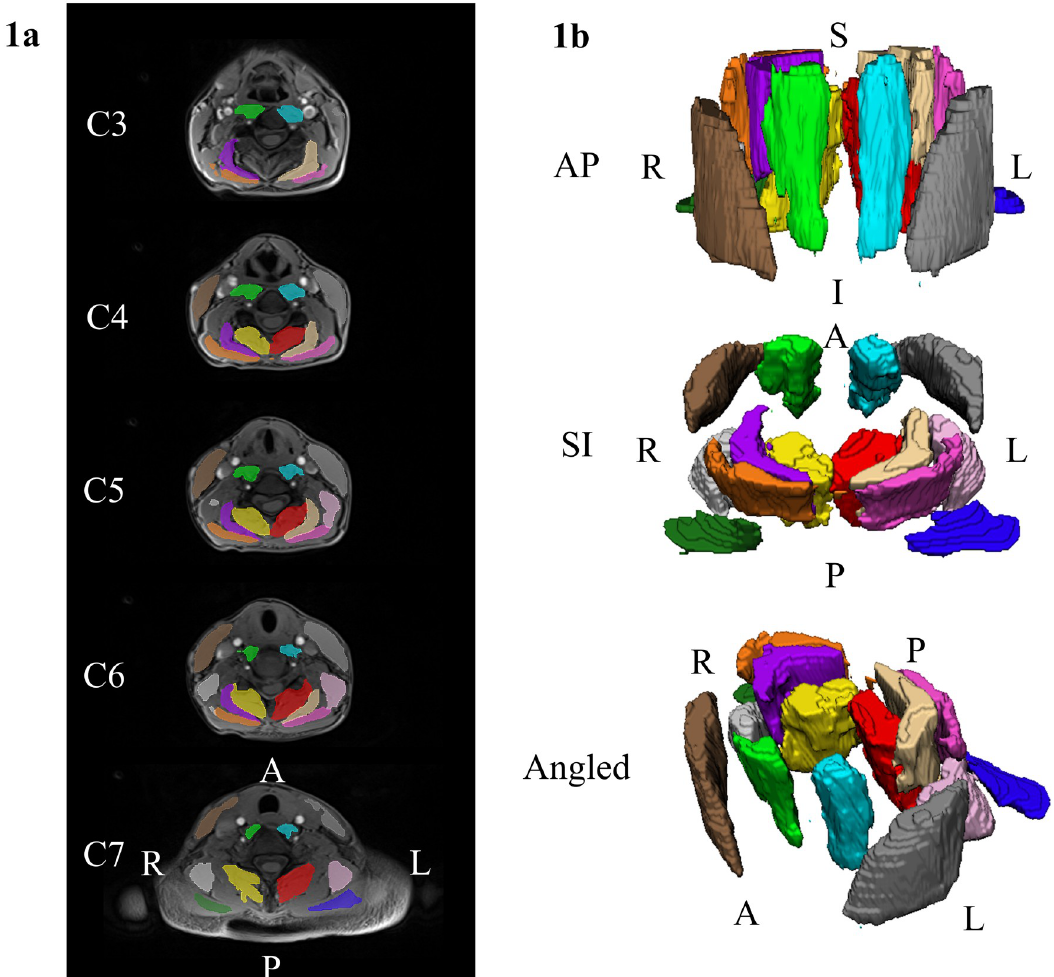
Fig 1. Example renderings of the cervical spine muscle segmentations. We used a previously developed convolutional neural network (CNN) to segment seven bilateral cervical muscles (14 muscles total). Example segmentations from a randomly selected DCM participant are shown. a) Two-dimensional renderings of the cervical spine segmentations at the C3 through C7 vertebral levels overlaid the axial water images. b) Three-dimensional renderings of the cervical spine muscle segmentations. The muscle groups segmented included the MFSS (left = red, right = yellow, LC (left = light blue, right = light green), SSCap (left = beige, right = purple), SPCap (left = dark pink, right = orange), LS (left = light pink, right = light gray), SCM (left = dark gray, right = brown), and TR (left = dark blue, right = dark green). L = left, R = right, A = anterior, P = posterior, S = superior, I = inferior. MFSS = multifidus and semispinalis cervicis, LC = longus colli and longus capitis, SSCap = semispinalis capitis, SPCap = splenius capitis, LS = levator scapula, SCM = sternocleidomastoid, TR = trapezius.